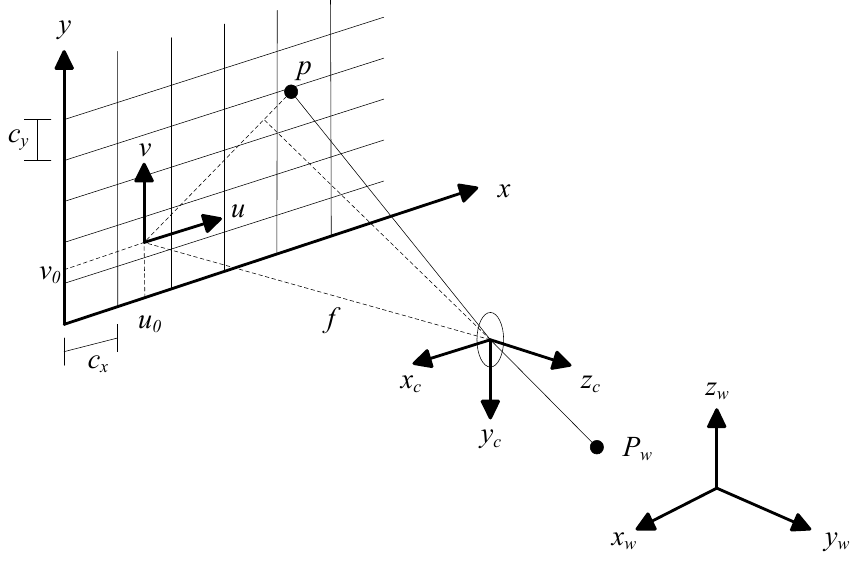
( d ) Figure 7. Image processing for vision tracking of brush position: ( a ) Region of interest; ( b ) Sub-pixel stripe center extraction; ( c ) Contour selection and connection; ( d ) Straight line fitting. 4. Calibration of the Optical Imaging System As presented in Figure 8, the calibration of the optical imaging system is to establish the coordinate conversion relationship from the spatial point